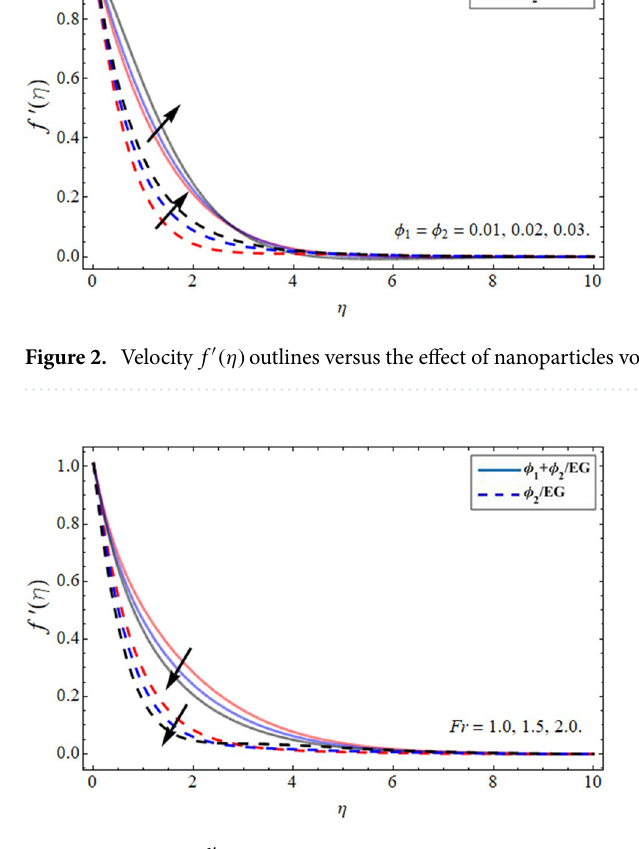
Figure 3. Velocity f ′ (η) outlines versus the effect of Darcy Forchhemier term Fr .